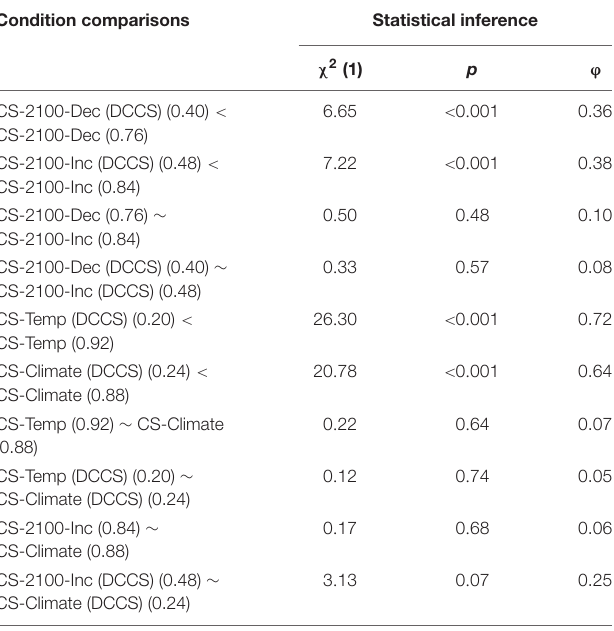
TABLE 2 | Comparison of different conditions involving violation of mass balance among participants. Condition comparisons Statistical inference